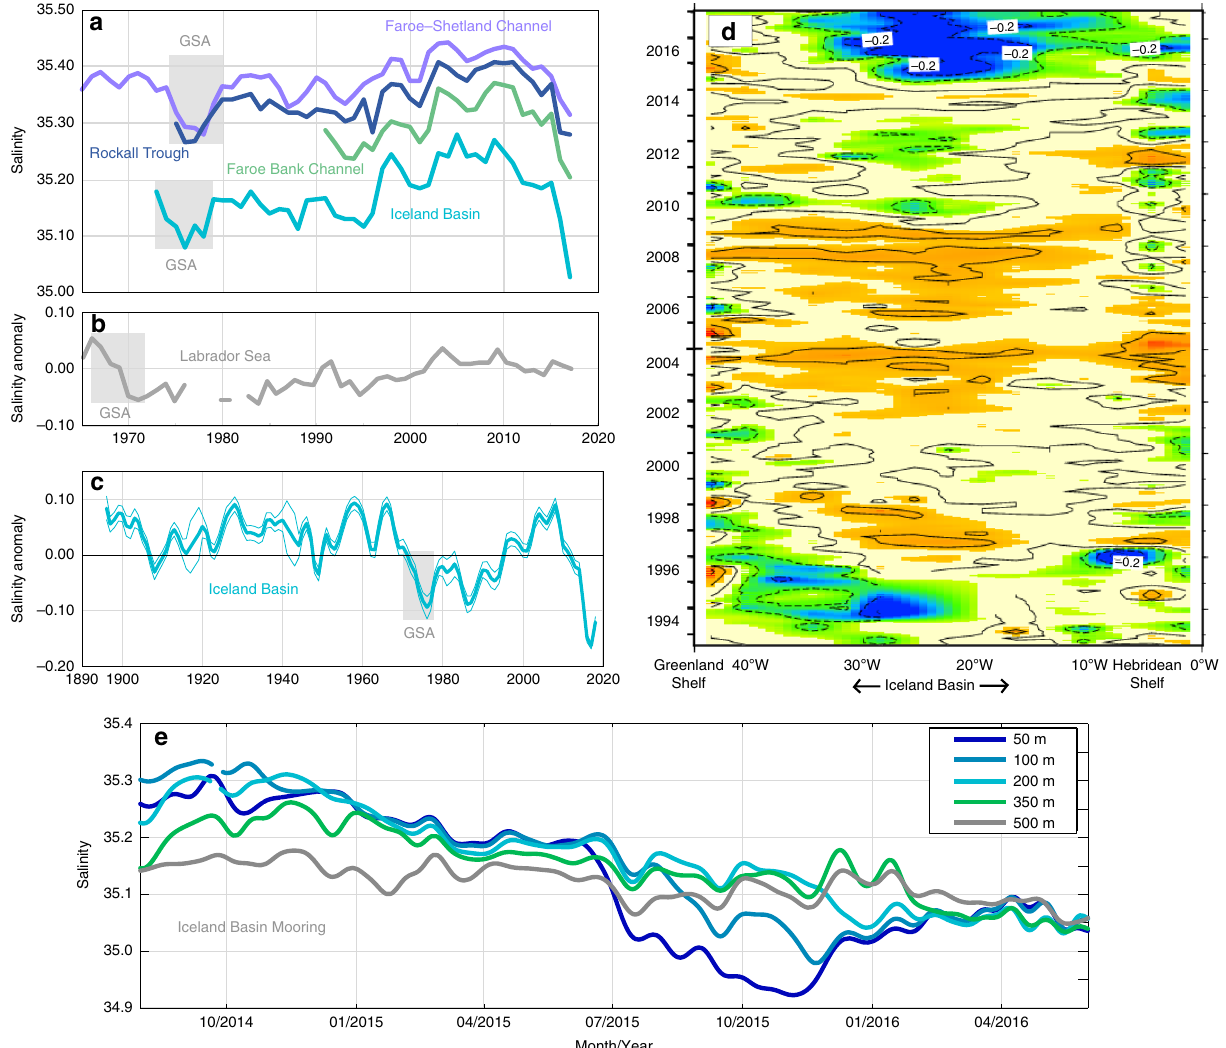
Fig. 4 Time series records of North Atlantic salinity. a annual mean upper ocean salinity from repeat hydrography sections in the Faroe Shetland Channel (North Atlantic Water salinity core, 0 – 200 m at 61°N 3°W), Rockall Trough (30 – 800 m at 57.5°N 11.0°W), Faroe Bank Channel (North Atlantic Water salinity core at 61.4°N 8.3°W) and Iceland Basin (Station Selvogsbanki 5, 63.0°N 21.5°W, 0 – 200 m), grey boxes indicate the Great Salinity Anomaly; b annual upper ocean (0-500 m) salinity anomaly (from seasonal means) from the interior Labrador Sea; c annual sea surface salinity records from the Iceland Basin (irregular polygon approximately 52-64°N, 10 – 20°W, thin lines indicate measurement error estimate); d Time-longitude plot of sea surface salinity anomaly at 60°N between Greenland and the Hebridean Shelf (mean is computed over 1993-2017, contour interval 0.1 psu, solid black line is zero). e A 2-year continuous record (2014 – 2016) of salinity observations at depths between 50 and 500 m at the M4 OSNAP mooring in the Iceland Basin (58.0°N,